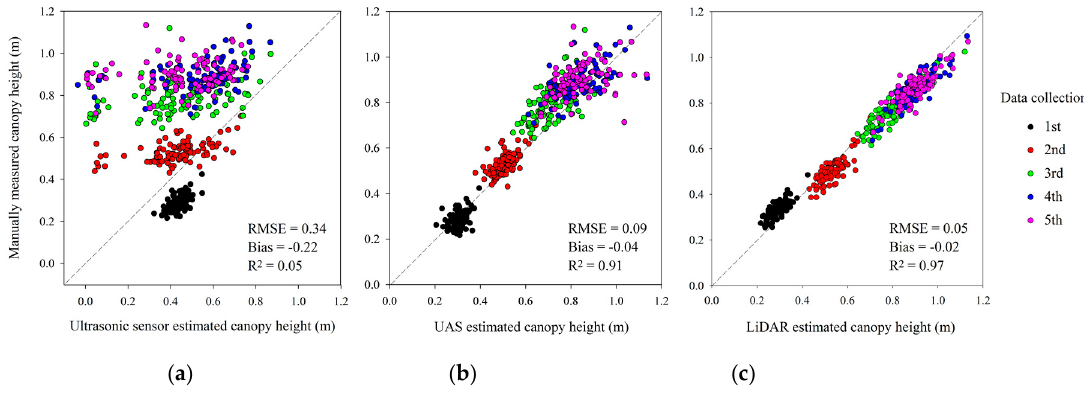
Figure 9. Manually measured canopy heights versus instrument estimated canopy heights: ( a ) ultrasonic sensors; ( b ) UAS; ( c ) LiDAR.